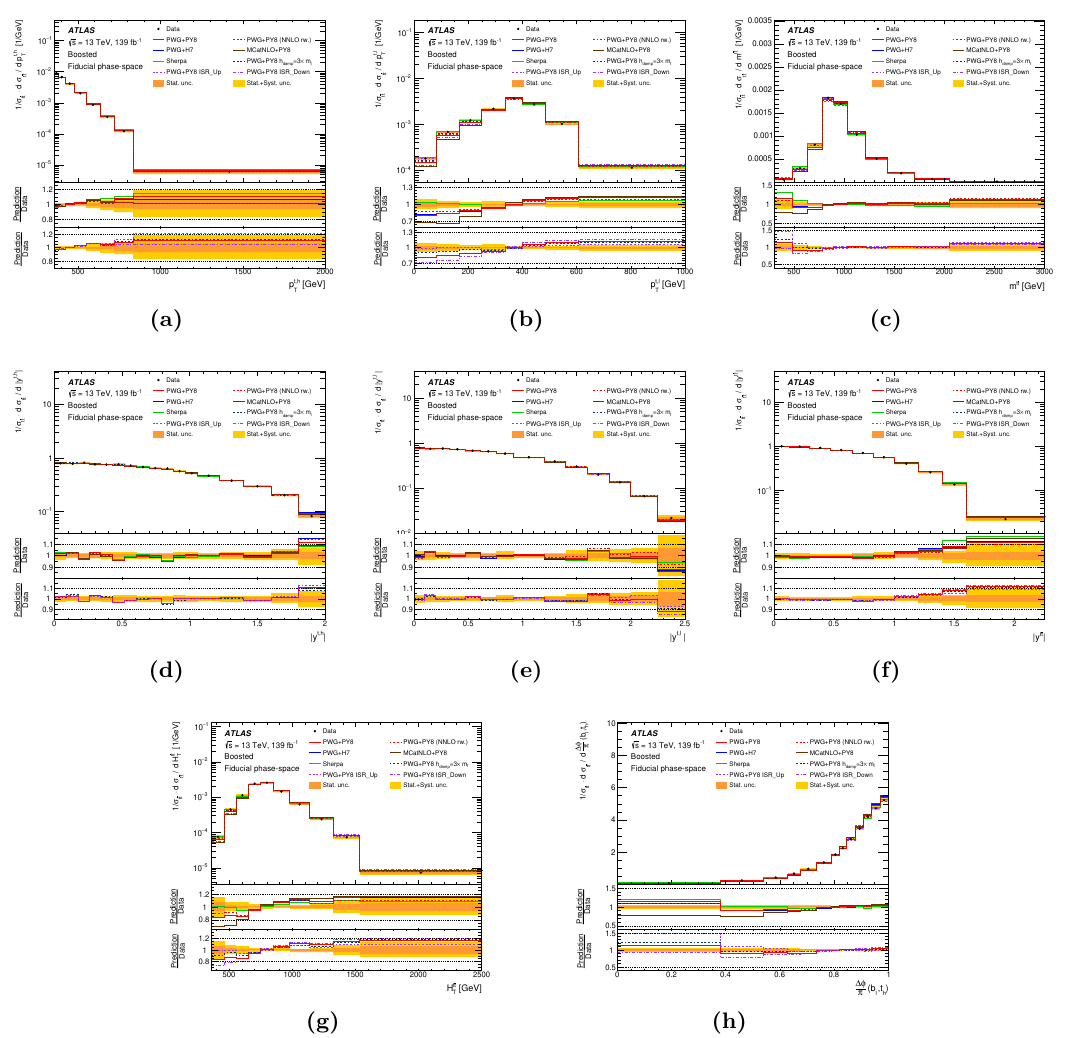
Figure 22. Normalised differential cross-section measurements for the observables related to the kinematics of the top quarks. The cross-section is shown as a function of (a) p t,h , (c) m t ¯ t , (d) | y t,h | , (e) | y t,‘ | , (f) | y t ¯ t | , (g) H t ¯ t p t,‘ T are compared with predictions from various MC generators. PWG+PY8 corresponds to the Powheg+Pythia sample, PWG+H7 to the Powheg+Herwig sample and MCatNLO+PY8 to the MadGraph5_aMC@NLO+Pythia sample. The orange band shows the size of the statisti- cal uncertainty and the yellow band shows the size of the total uncertainty. The lower two panels in each subfigure display the ratios of the different predictions to the